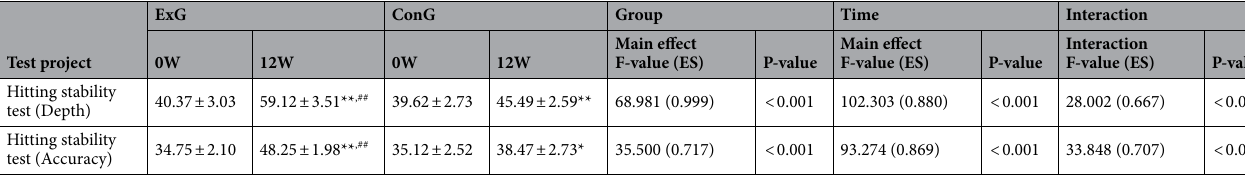
Table 8. Subjects’ batting stability 2 × 2 repeated measures ANOVA test. Within-group differences *P < 0.05, **P < 0.01; Differences between groups # P < 0.05, ## P <